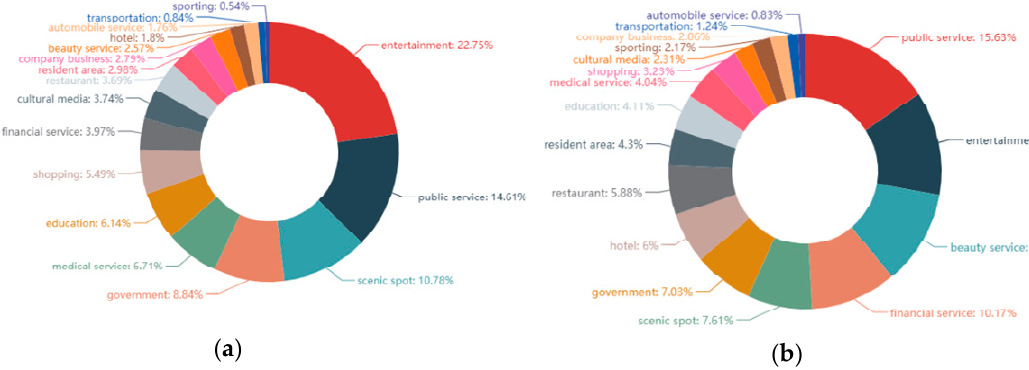
Figure 4. Examples of the function distribution in functional regions. ( a ) Region 155; ( b ) Region 156.